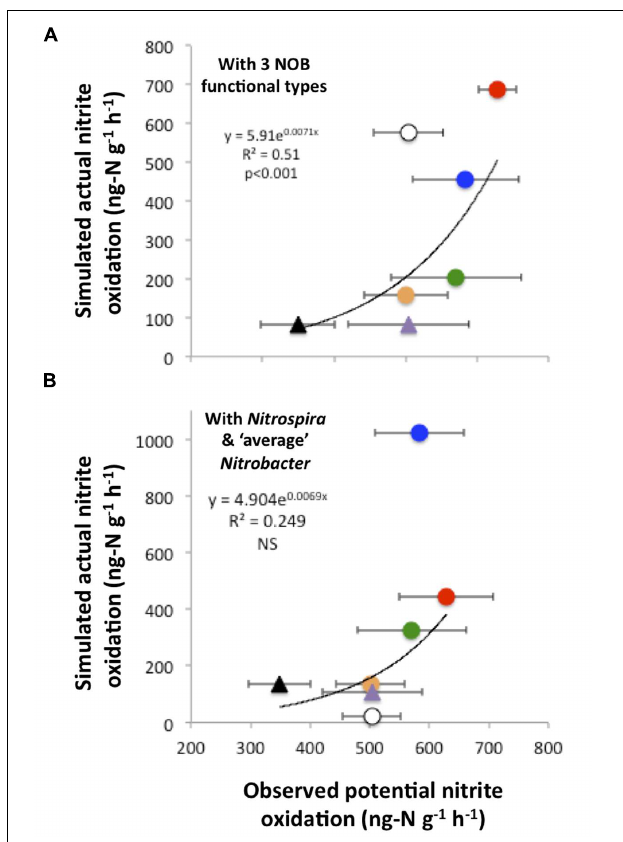
FIGURE 5 | Simulated actual nitrite oxidation compared to observed potential nitrite oxidation. The relationship is presented when using the trait-based model with three functional types of nitrite-oxidizing bacteria (A) . For comparison, results are presented when disregarding the functional diversity within Nitrobacter , i.e., considering only Nitrospira and ‘average’ Nitrobacter (B) . Each point corresponds to one global change scenario, and observed mean values are presented with standard errors. Symbols are as in Figure 4